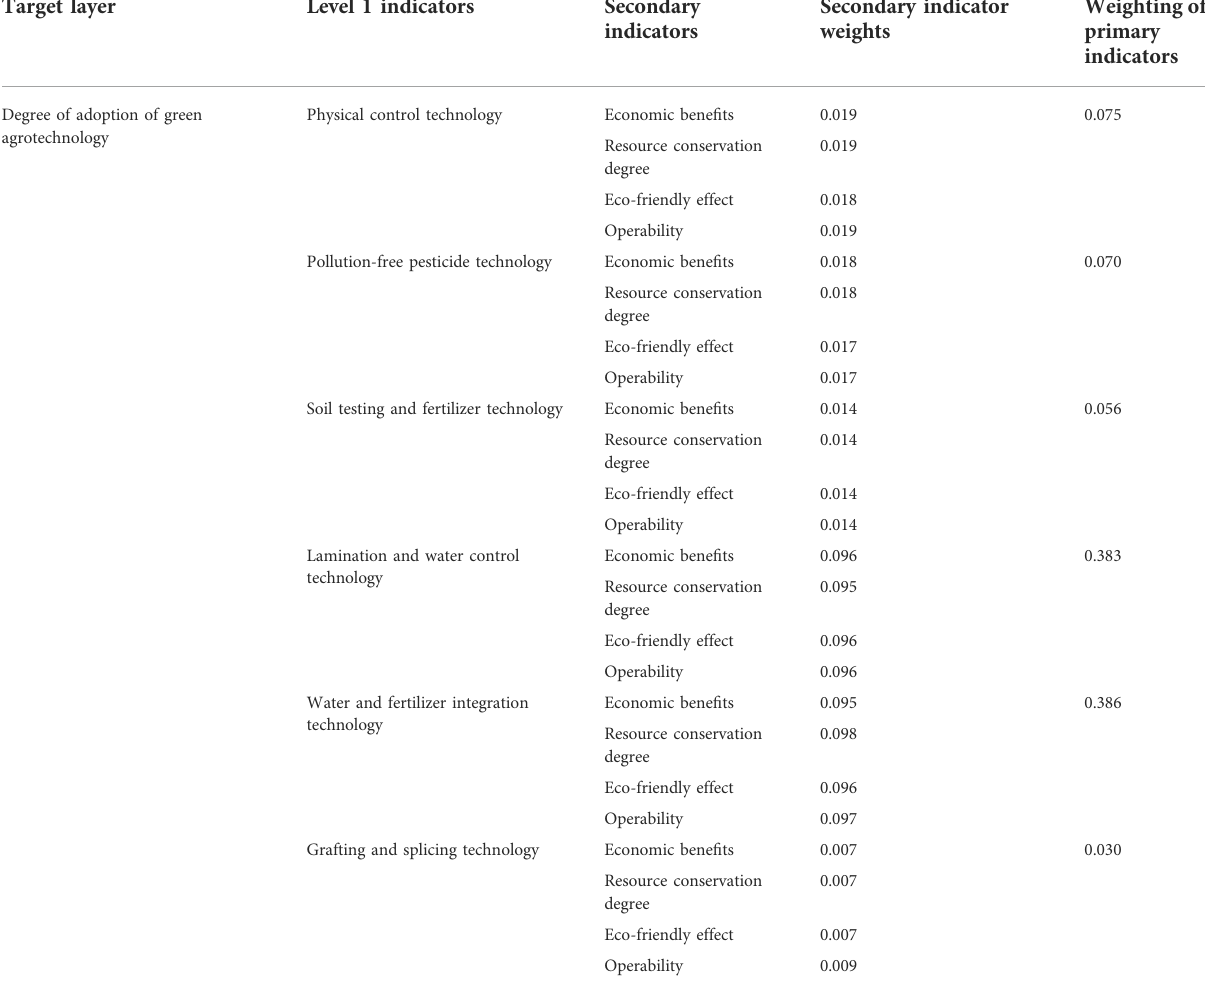
TABLE 2 Evaluation indicators and weights of the degree of adoption of various types of green agrotechnology by resettled